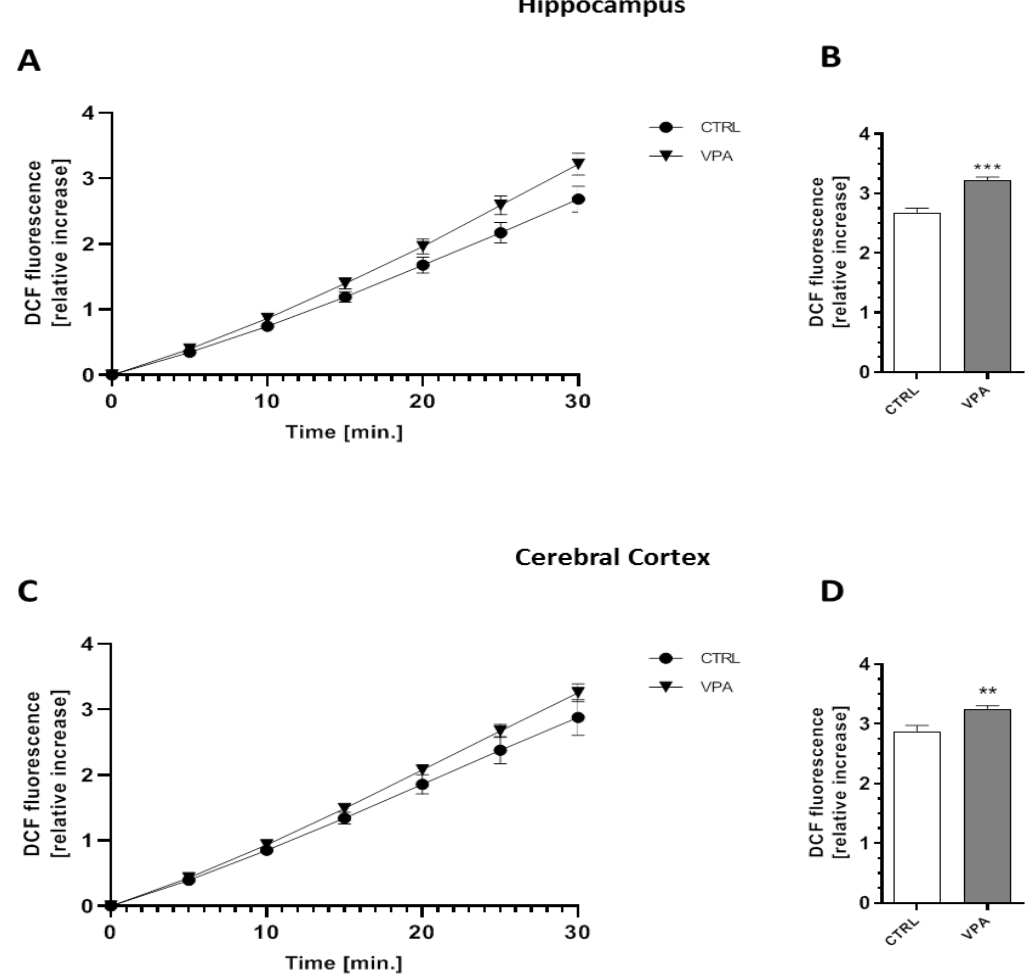
Figure 8. The e ff ect of prenatal exposure to VPA on free oxygen radicals (ROS) generation. The level of ROS was determined using a fluorescent probe (H 2 DCF-DA) on the hippocampus and cerebral cortex of the control and VPA-exposed animals for 30 min (( A , C ), respectively) and after 30 min (( B , D ), respectively). The results are presented as the relative increase in fluorescence. Data represent the mean values ± SEM from n = 8 independent experiments in both the hippocampus and cerebral cortex. ** p < 0.01, *** p < 0.001 vs. control.